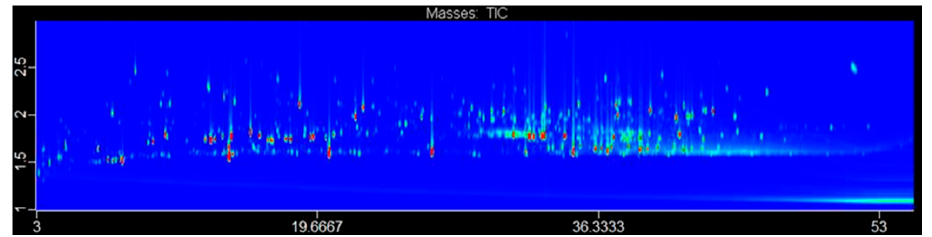
Figure A2. Box plot of three condition classes based on the sum of 1655 peak areas per sweat sample.